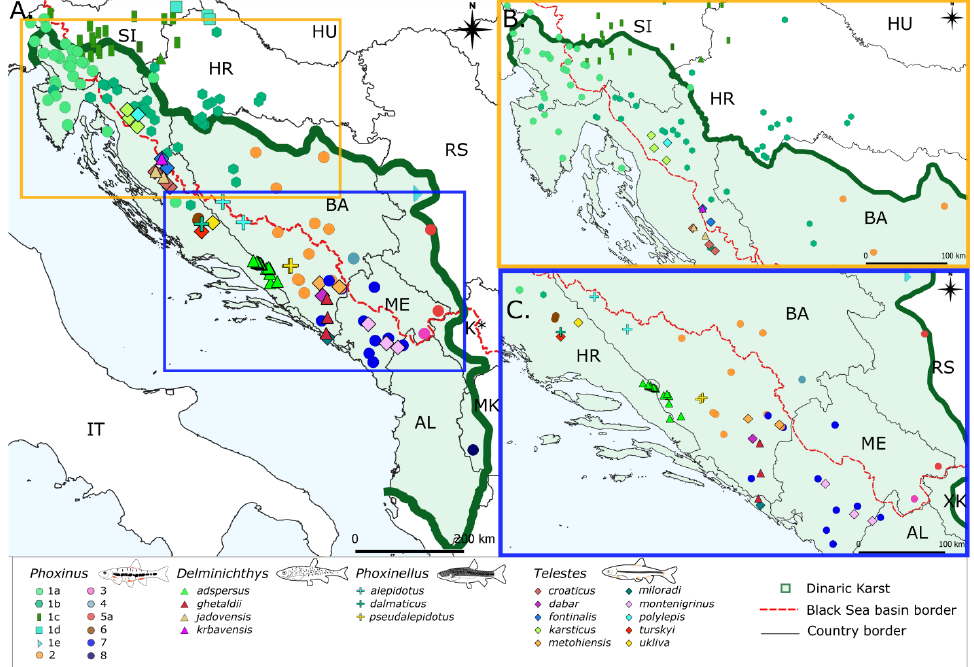
Figure 2. Distribution of mitochondrial (mt) lineages of the four fish genera Phoxinus , Delminichthys , Phoxinellus , Telestes in Dinaric Karst. In Phoxinus , not all lineages and sub-lineages represent valid species, and thus, they are encoded according to Palandačić et al. [ 37] (1a – 1e, 2 – 4, 5a, 6 – 8). In the other three genera, Deliminichthys , Phoxinellus and Telestes , the mt lineages correspond to species, and thus, species names were used. ( A ) Overview of Dinaric Karst ( B ) Enlargement of the northern part of Dinaric Karst (framed in orange) ( C ) Enlargement of the southern part of Dinaric Karst (framed in blue). Phoxinus sub-lineages 1a–1e are represented with symbols shown in the